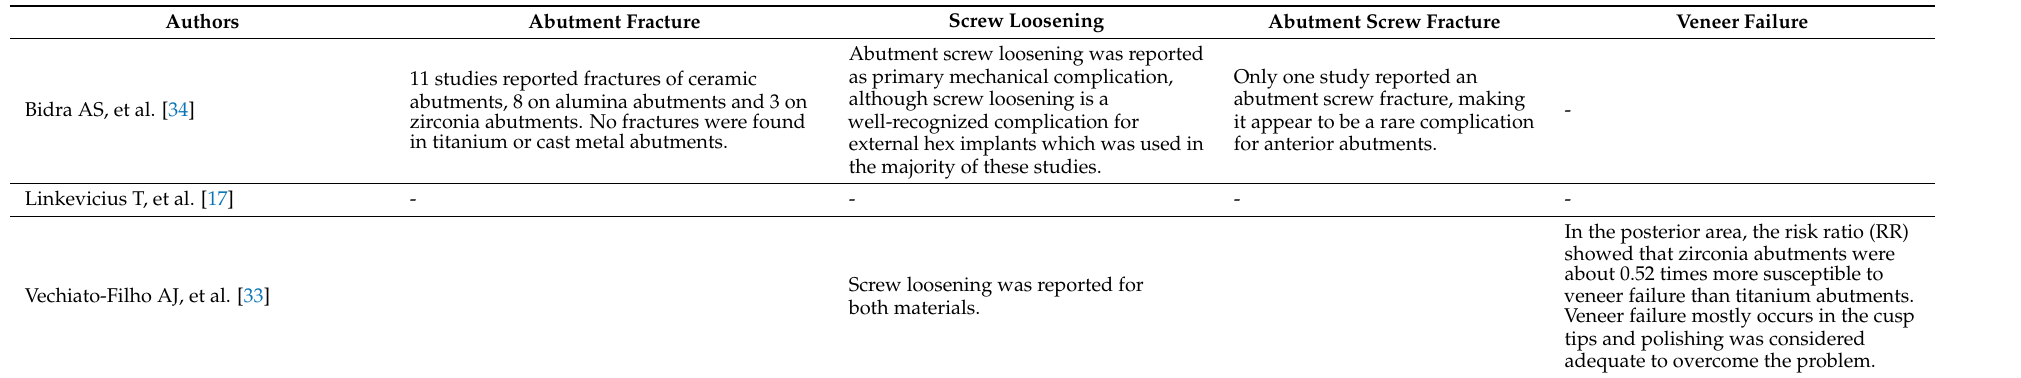
Table 4. Mechanical outcomes reported in included systematic